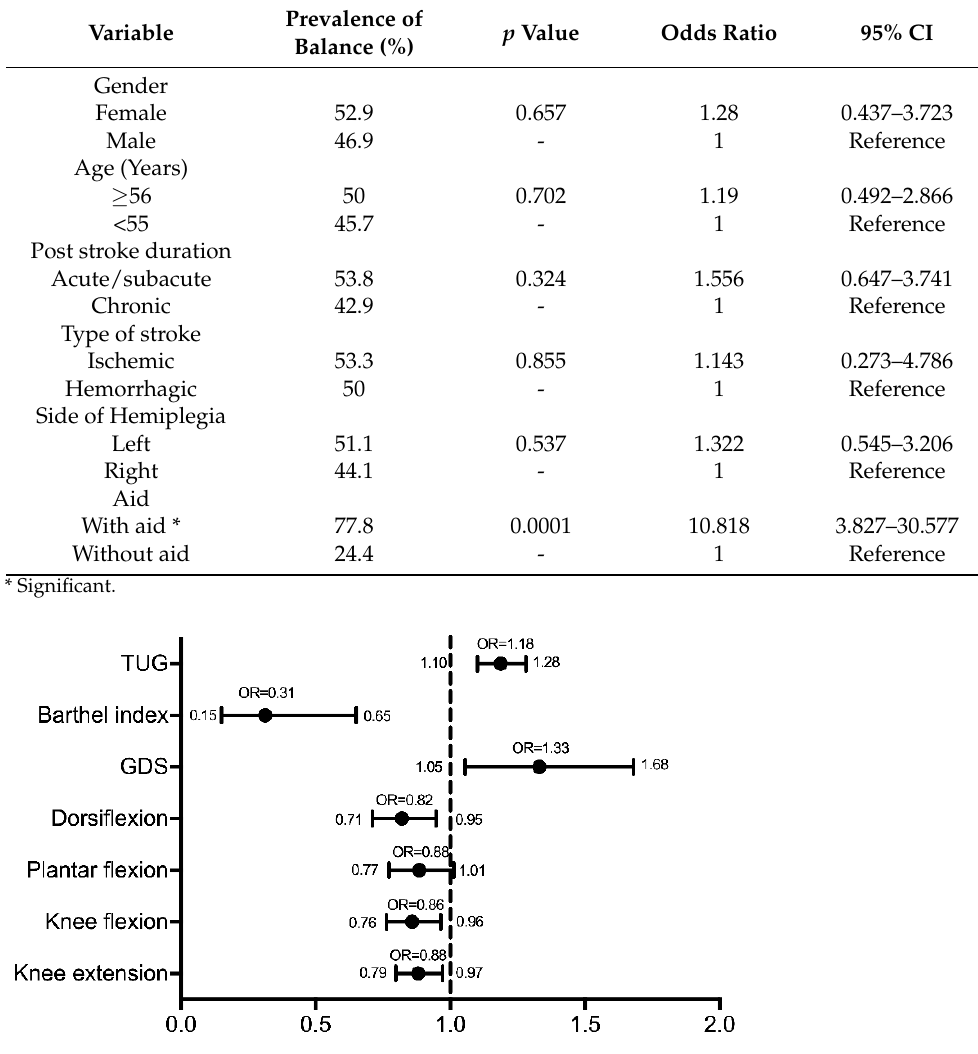
Figure 2. Relation between balance (BBS) and Barthel index (BI): ( A ) correlation between BBS and BI; ( B ) regression curve on BBS and BI; ( C ) ROC curve between BBS and BI. 4. Discussion The study assessed the prevalence of balance impairment in patients with stroke and the factors associated with balance impairment in four hospitals in Saudi Arabia. The as- sessment of balance in patients with stroke should be considered with importance, as it is a significant predictor of long-term physical function, mobility and perceived recovery. The results of the current study are expected to be of help to researchers and clinicians in evaluating and planning effective treatment strategies. The existing data available are from western countries [21], subcontinents [29], and Africa [22]; however, the data from the Arab population were deficient, thus making their future study necessary. The mean age of the subjects with stroke in this study was 58.36 ± 14.06; however, the mean ages of stroke subjects in studies from developed countries were higher, while those from the subcontinent were lower, and those from Africa were similar to the results in this study [21,22,29]. Nevertheless, these distinctions underpin the desideratum of prevalence data from these kinds of studies. The prevalence of balance impairment in this study was 48.1%, indicating that the impairment was present in half of the stroke survivors. The data on prevalence reported from previous studies were in contrast to this study’s findings. The results from a previous study in the United Kingdom reported a high prevalence of balance (83%) [21]. It is im- portant to note that the study was conducted in the acute period, in which the mean du- ration was 21 ± 5 days, which could have resulted in such a high prevalence. However,